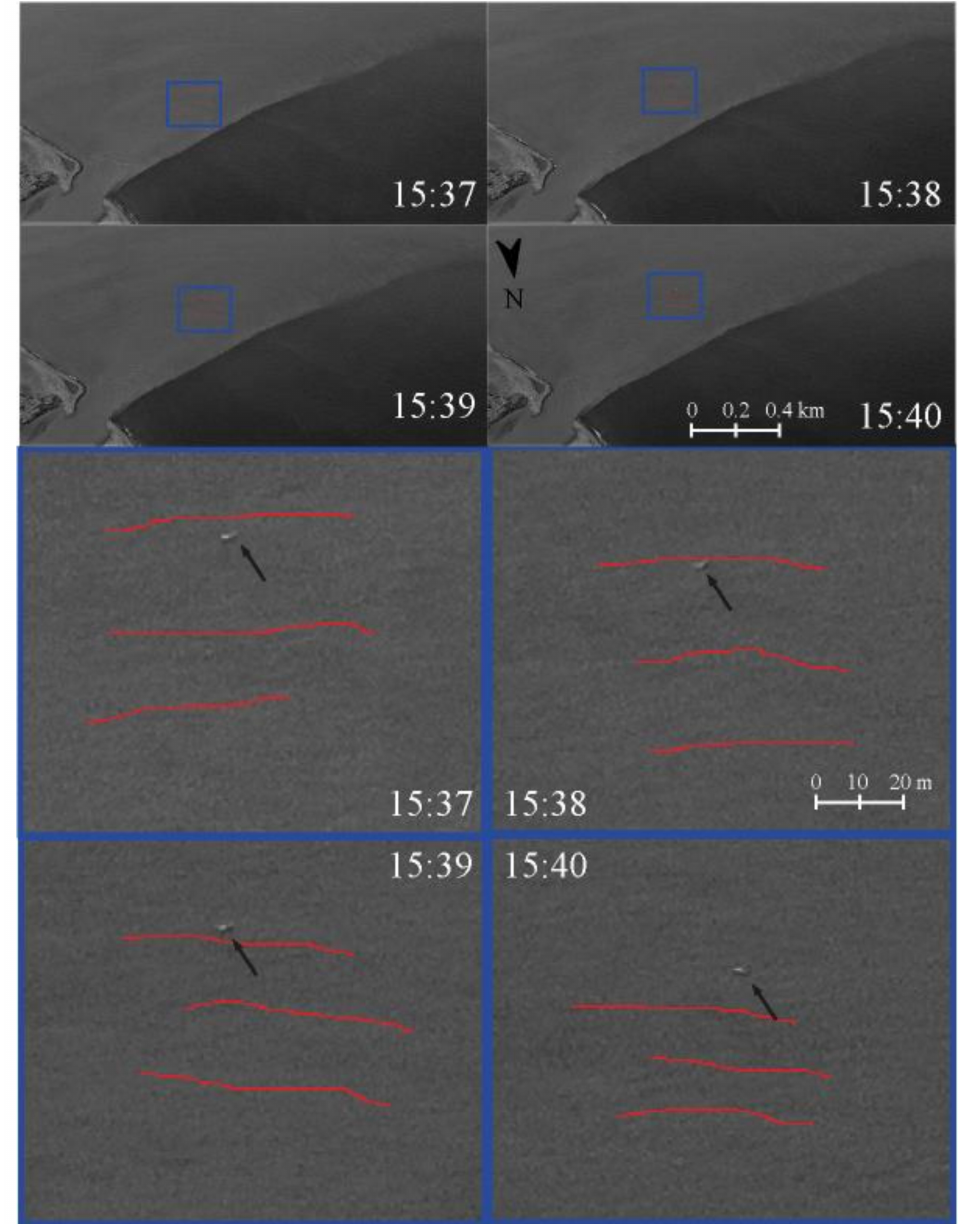
Figure 4. Processed aerial images of the Bzyb plume on 16 April at 15:37–15:40 during the first drifting boat experiment. Top images show the near-field part of the Bzyb plume; bottom images show the zoomed-in areas (indicated by the related blue squares in the top images). Red lines indicate ring-like features; black arrows indicate location of the free-drifting boat. Note that the frame of the bottom images is